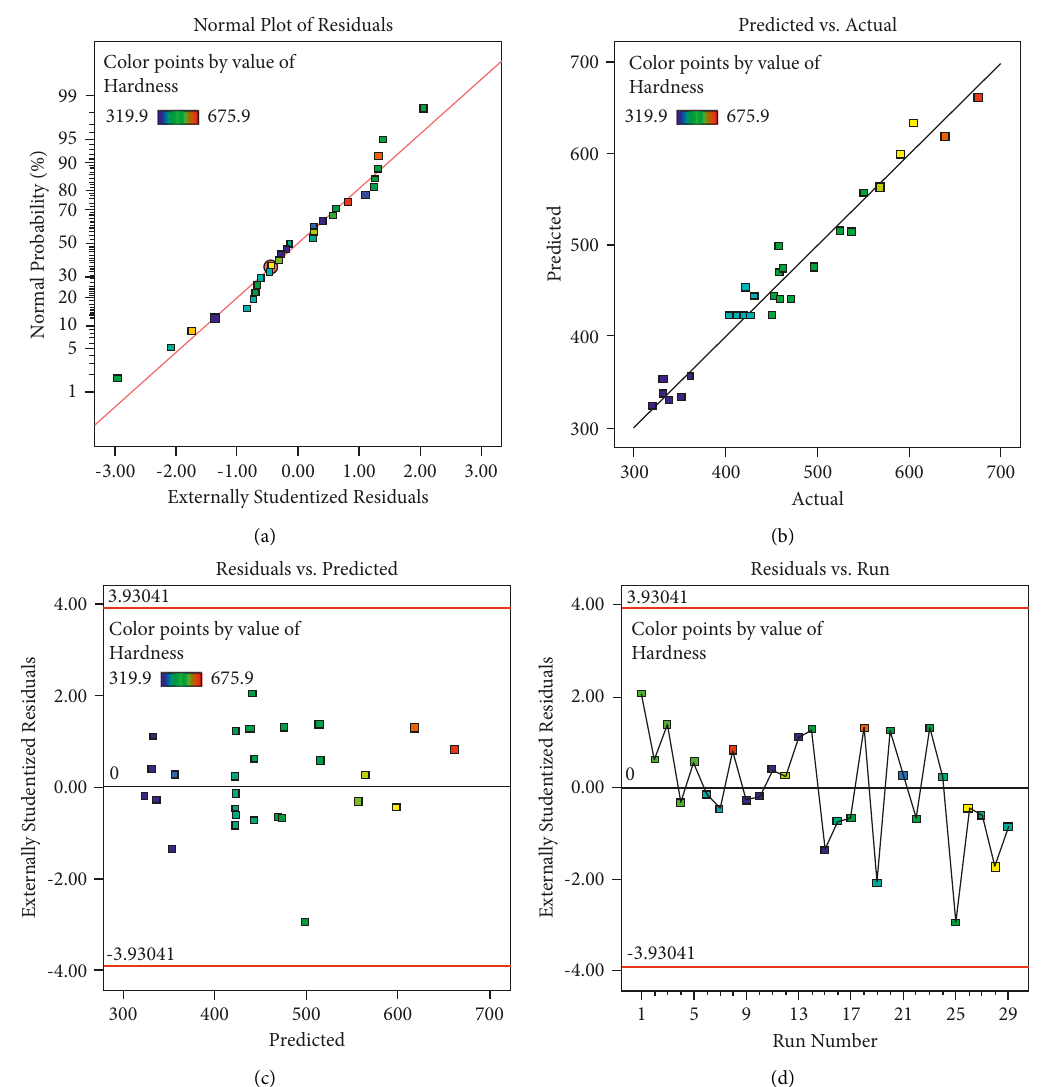
Figure 11: Diagnosis diagram of the coating hardness model. (a) The normal distribution of residuals. (b) Projected and actual values. (c) Predicted values and residuals. (d) Serial number and